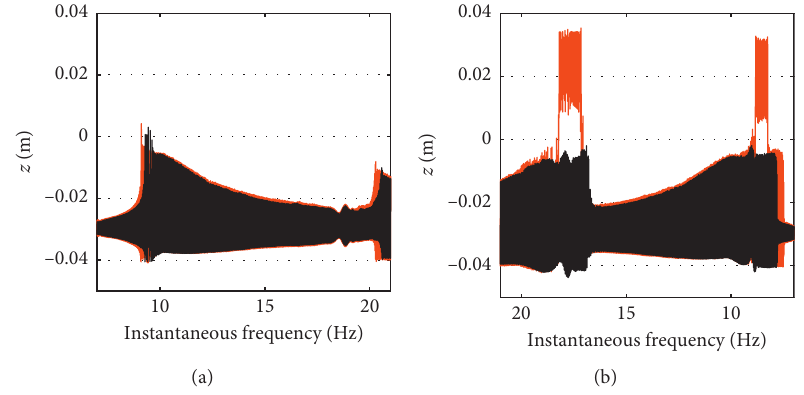
Figure 9: Sine-sweep tests. Black line: b